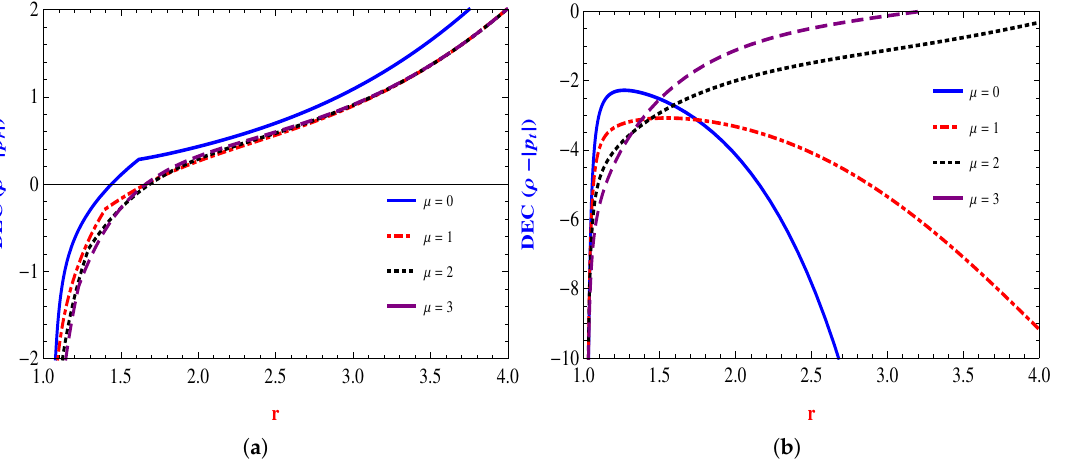
Figure 12. Plots: ( a ) Radial DEC ( ρ − | p r | ) , and ( b ) Tangential DEC ( ρ − | p t | ) with throat radius r 0 = 1 and α = − 0.1 in f ( Q ) = Q + α Q